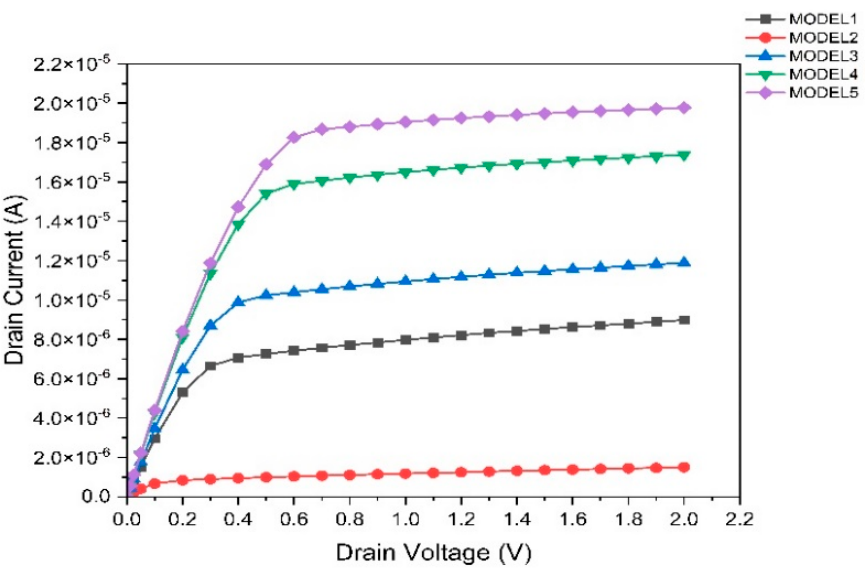
Figure 8. Output characteristic curves for five independently controlled SOI FinFET devices under different modes of operation.